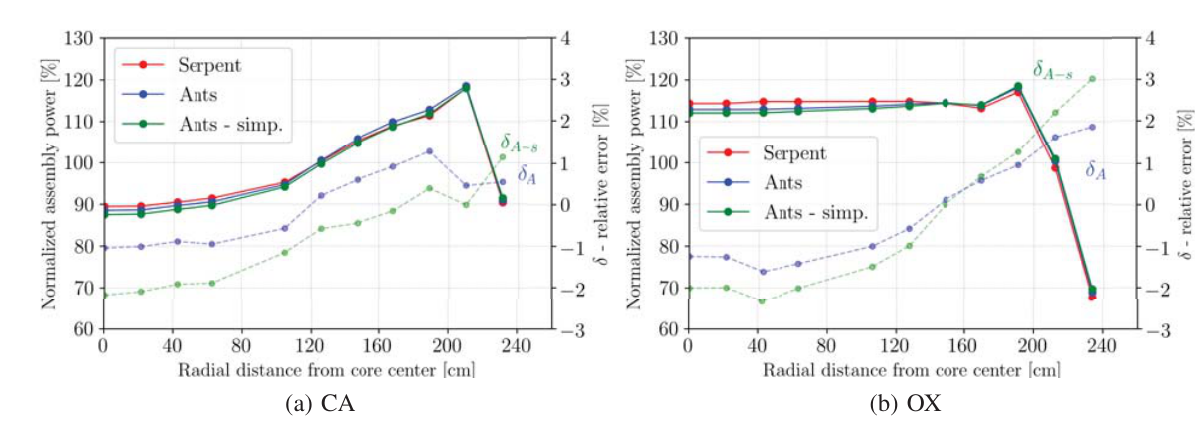
Figure 6: Radial Power Profiles (in Main Diagonal.